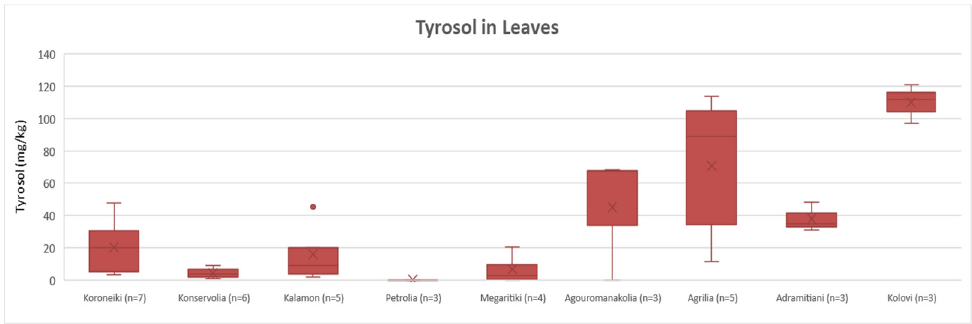
Figure 4. Box and whisker plot for the concentrations of tyrosol among different varieties of leaves. Hydroxytyrosol